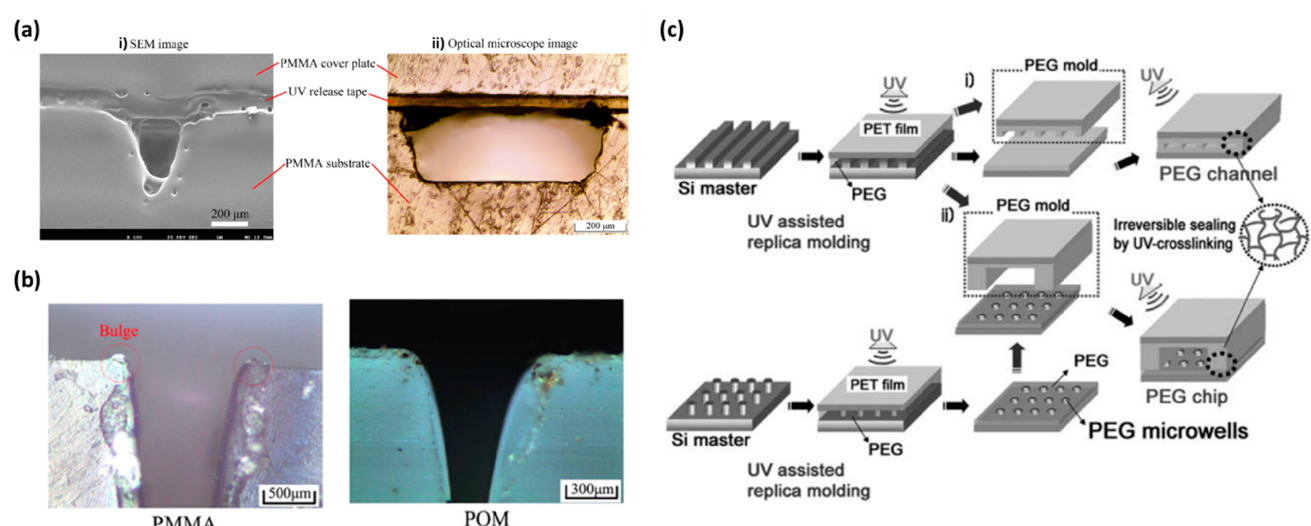
Figure 2. ( a ) ( i ) SEM image of PMMA microchannel’s cross ‐ section fabricated by CO 2 laser ablation ( ii ) Optical image of PMMA microchannel’s cross ‐ sectional fabricated by micro ‐ milling technique. Reproduced with permission [70] 2022, Springer. ( b ) Optical images of PMMA and POM microchannels’ cross ‐ sections fabricated by laser ablation. Reproduced with permission [72] 2022, Springer. ( c ) Fabrication of PEG layers containing microchannels or microwells features and bonding to flat PET or PEG layers through UV polymerization technique. Reproduced with permission [97] 2022, Royal Society of Chemistry. Table 1. Common approaches for forming microchannel.